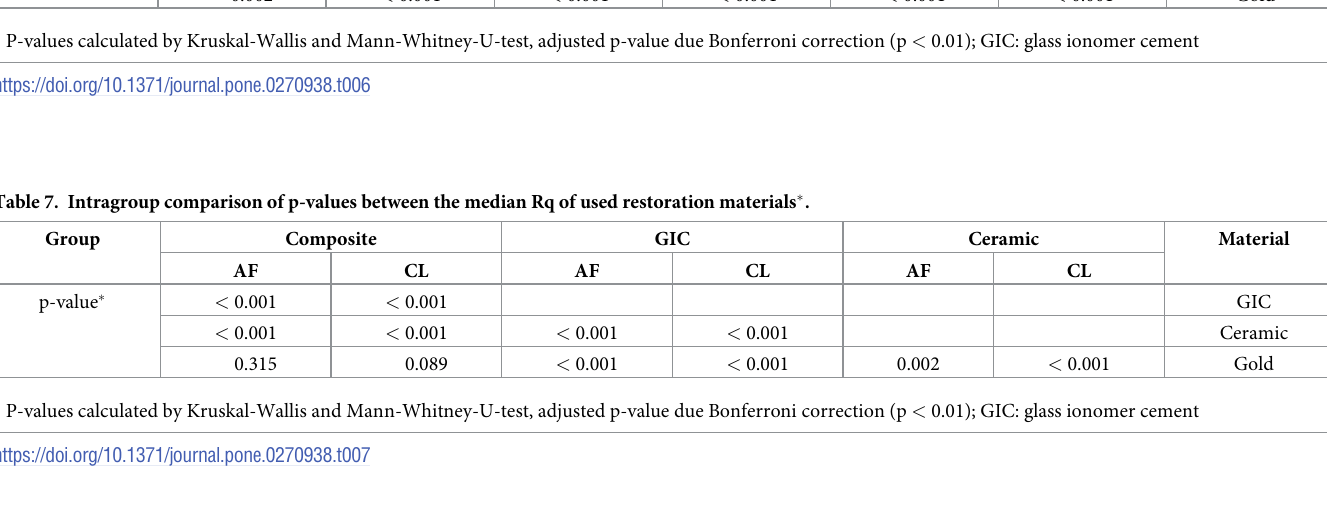
� Differences between test groups were statistically significant in the intergroup comparison p < 0.05 by Mann-Whitney-U-test. Marked values were statistically significant lower.